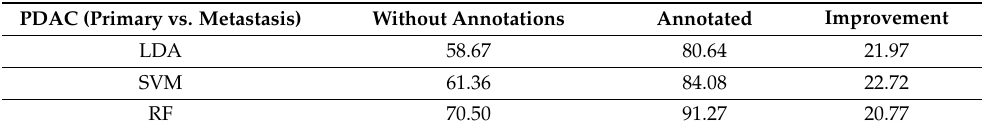
Table 2. Classification accuracies of the different supervised classification models using primary pancreatic ductal adenocarcinoma (PDAC) samples and distant metastasis in direct comparison with the same samples considering the histological annotations of the epithelial regions. PDAC (Primary vs. Metastasis)